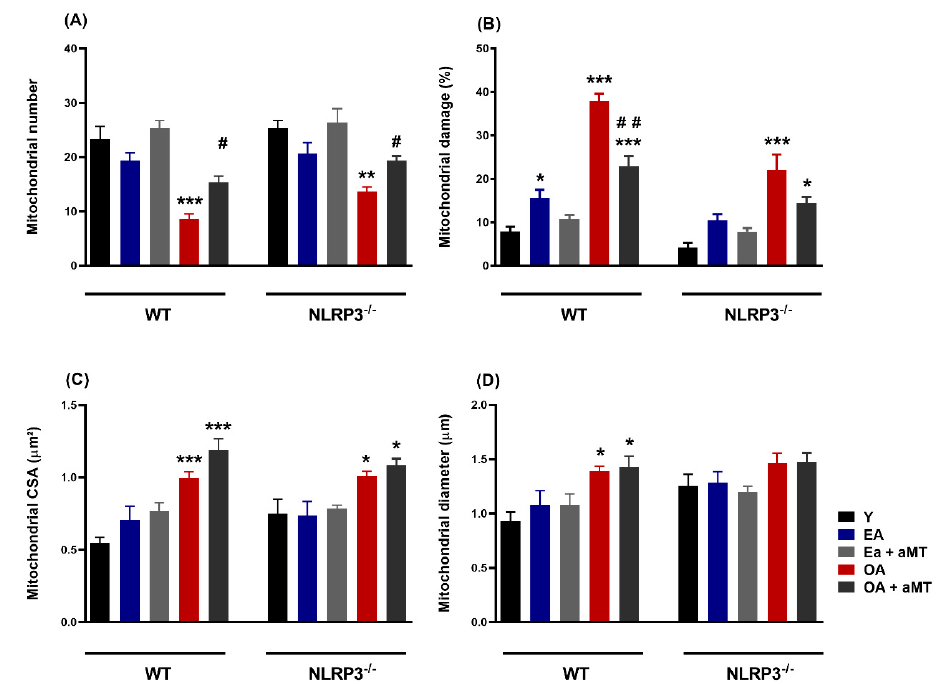
Figure 8. Age-associated morphometrical changes of intermyofibrillar mitochondria in cardiac muscle fibers of WT and NLRP3 − / − mice and melatonin treatment. ( A ) Analysis of mitochondrial number. ( B ) Analysis of mitochondrial damage percentage. ( C ) Analysis of cross-section area (CSA, µ m 2 ). ( D ) Analysis of mitochondrial Feret’s diameter ( µ m). Data are expressed as means ± SEM ( n = 7 animals / group). * p < 0.05, ** p < 0.01, *** p < 0.001 vs. Y; # p < 0.05, ## p < 0.01 vs. group without melatonin treatment.